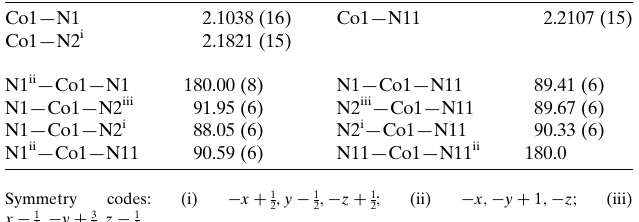
Table 2 Hydrogen-bond geometry (A˚ , (cid:4)